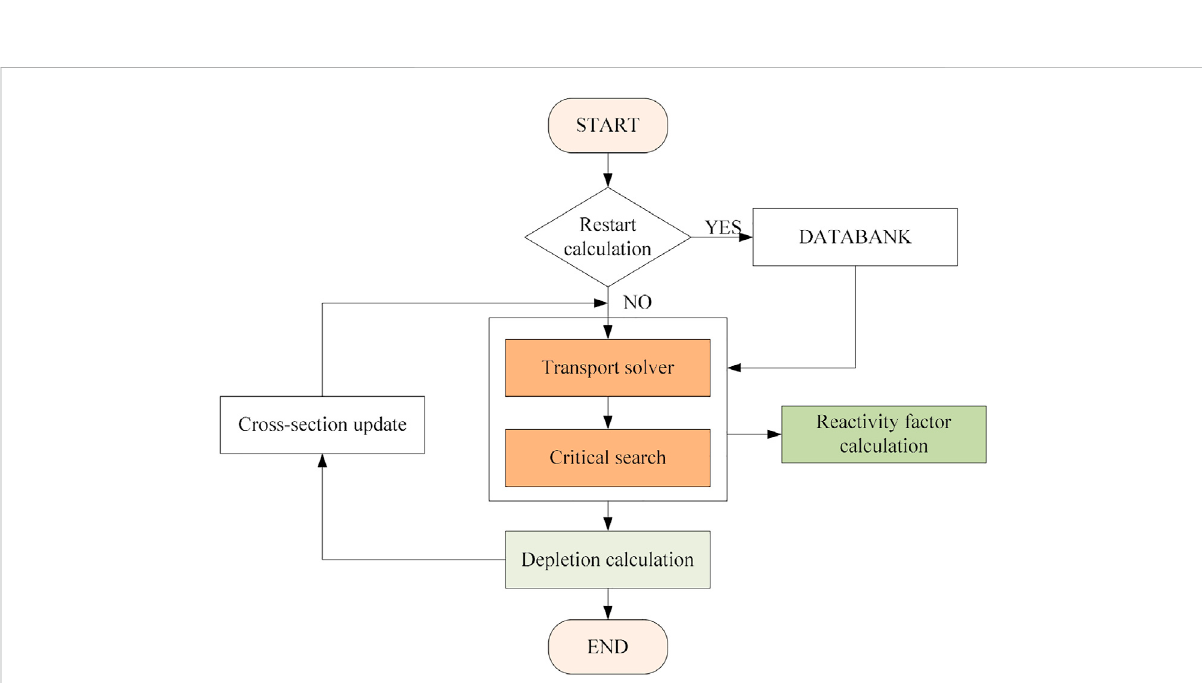
FIGURE 1 The calculation process of MOCS.